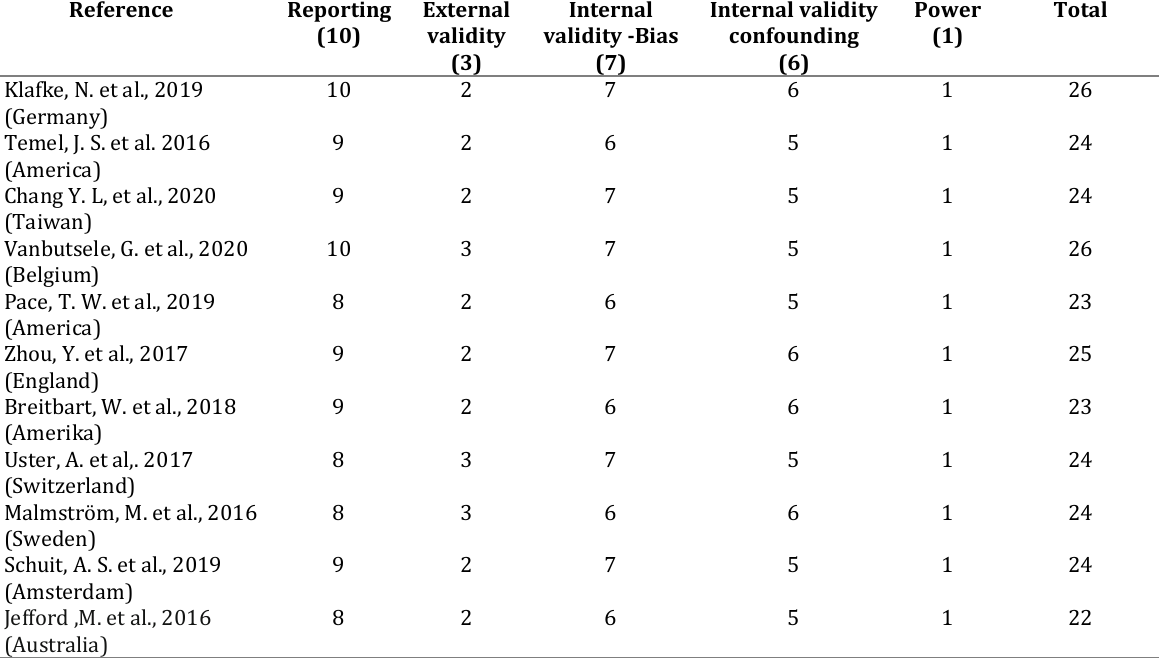
Table 2. Quality assessment scores of included studies, using Downs and Black